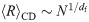
Schematic illustration of our polymer model for CDs.(A) A nucleosome fiber is represented as a polymer bead chain and forms a CD. The size scaling of CDs is expressed as 〈R〉CD∼N1/df, where the fractal dimension represents the effective conformational state of CDs: df = 1, 2, and 3 correspond to a straight line, the ideal chain, and the fractal globule, respectively. (B) The viscoelasticity of the medium, where the movement of particles shows the subdiffusive FBM 〈Δr(t)2〉∼tα, is described using the friction coefficient with memory, γ(t)∼t−α. When a nucleosome with coordinates Rn(t) dynamically fluctuates in the viscoelastic medium, the movement of nucleosomes in CDs shows subdiffusion: 〈ΔRn(t)2〉∼tβ.